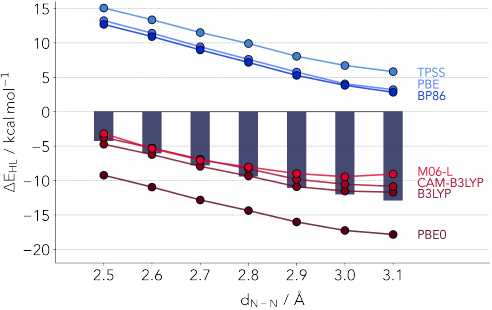
Figure 2. Overview of the DFT ∆ E HL in relation to the coupled cluster values (bars). In absolute